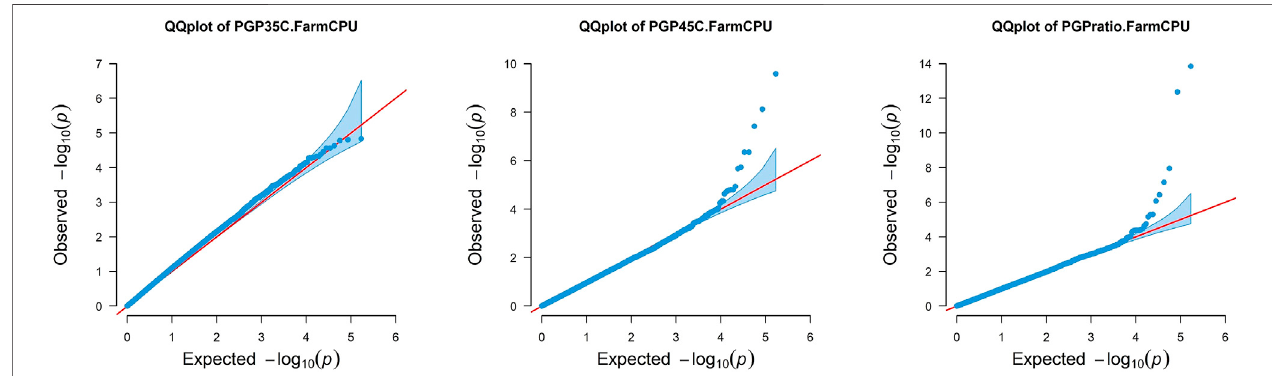
FIGURE 1 | Quantile-quantile (Q-Q) plots using Q + K FarmCPU model, showing comparative rise of expected − log 10 p -values on x-axis against observed − log 10 p -values on y-axis for each trait. PGP35 ° C: Pollen Germination percentage at 35 ° C; PGP45 ° C: Pollen Germination percentage at 45 ° C and PGP Ratio: Pollen Germination percentage ratio between 35 and 45 °